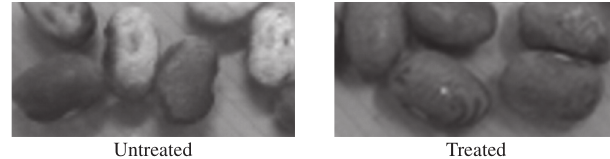
Figure 6. Reproducibility test in QCM system using 2-propanol in several cycles a) and acetone before b) and after c) several exposures.